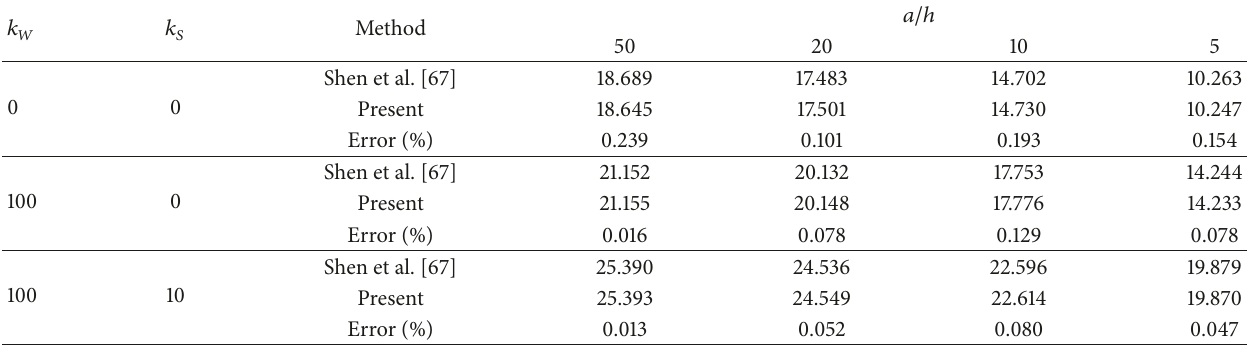
Table 2: Frequency parameters Ω for angle-ply (0/90 ∘ /0) square plate with simply supported boundary constraints and different foundation parameters and length-thickness ratios (Material II)